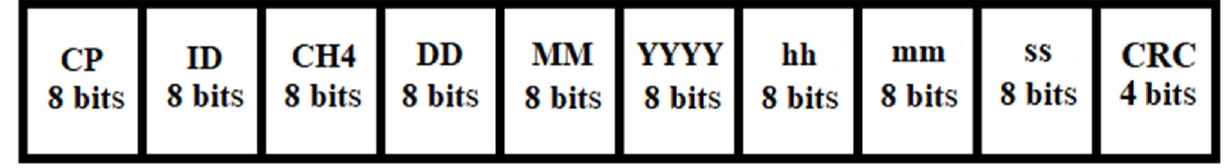
Figure 18. The data frame that is send by the miner’s cap lamp. Manchester coding has a logical 0 bit coded through a high–low transition (10), and a logical 1 bit coded through a low–high transition (01). The data transmission algorithm from mining lamps to a specific VLC receiver is presented in Figure 19.